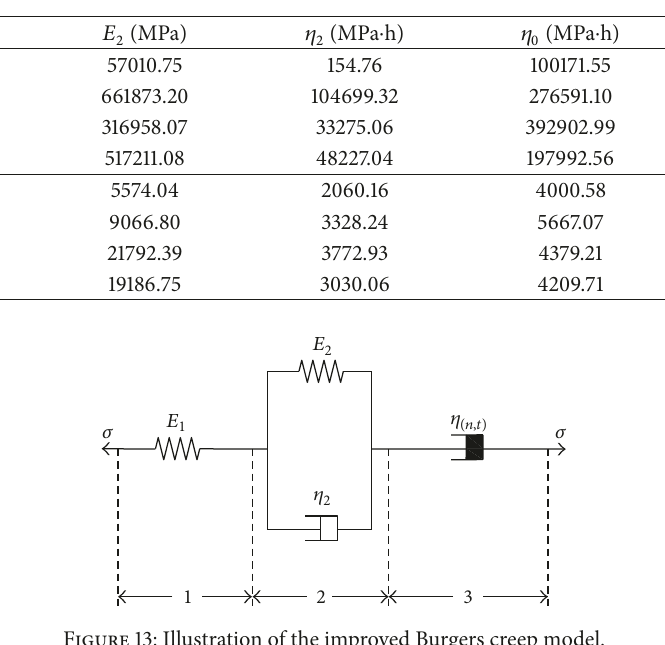
Table 2: Improved Burgers creep model parameters of red sandstone.